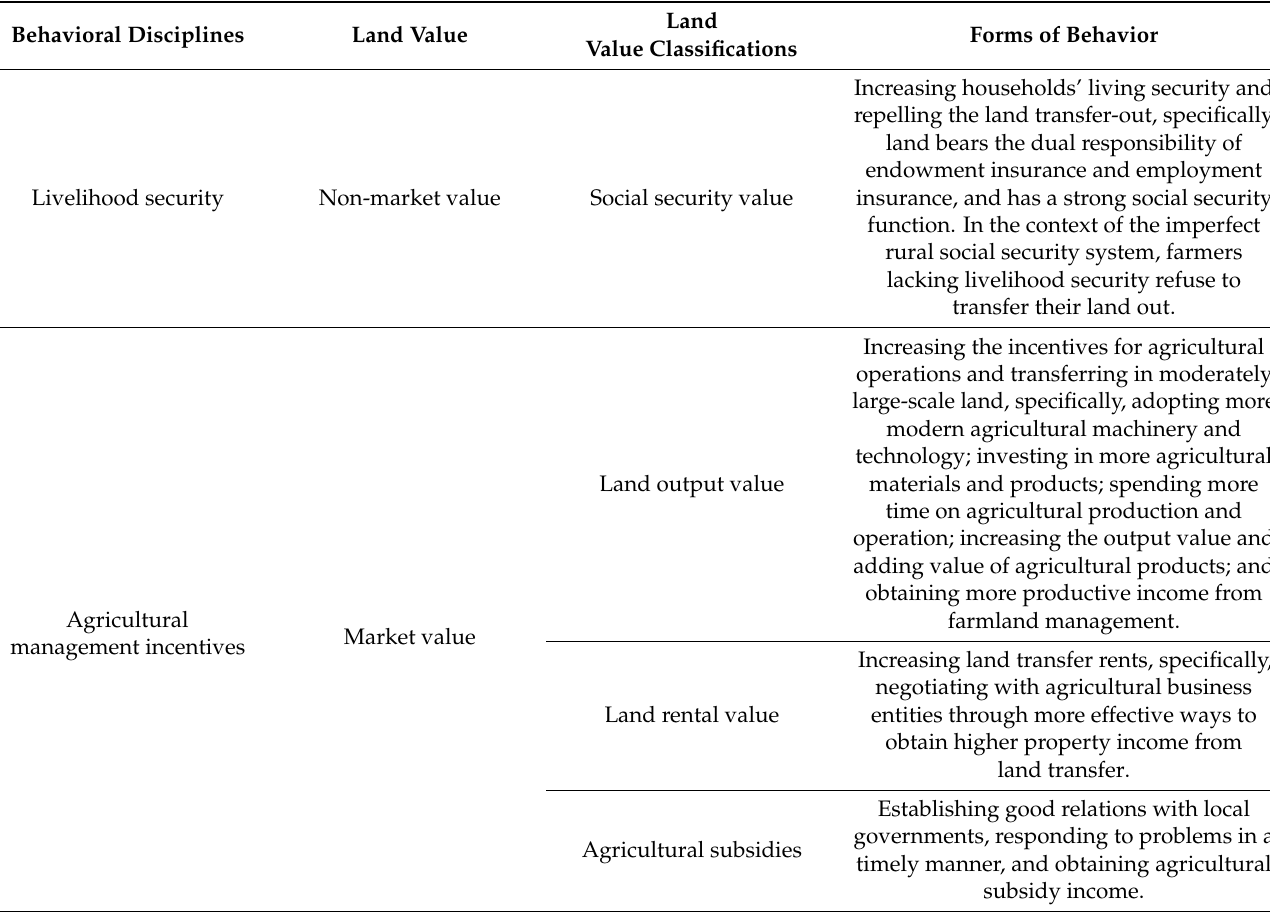
Table 1. Behavioral disciplines, land value, and forms of